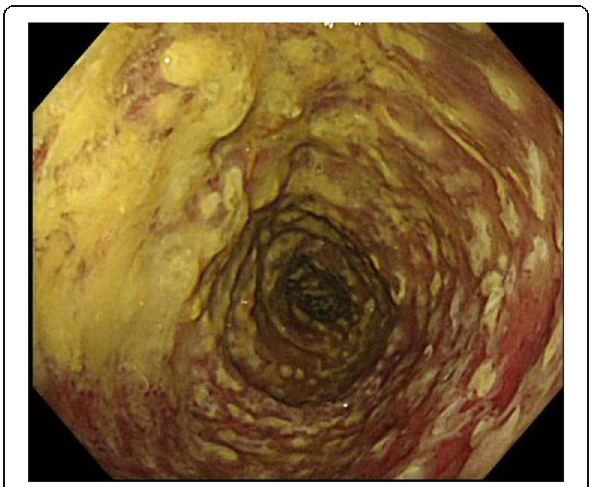
Fig. 3 Colonoscopy on the 7th postoperative day revealed the adhesion of white leaves to the whole large intestine